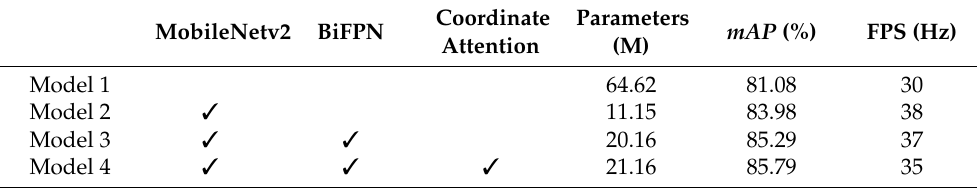
Table 1. Model performance